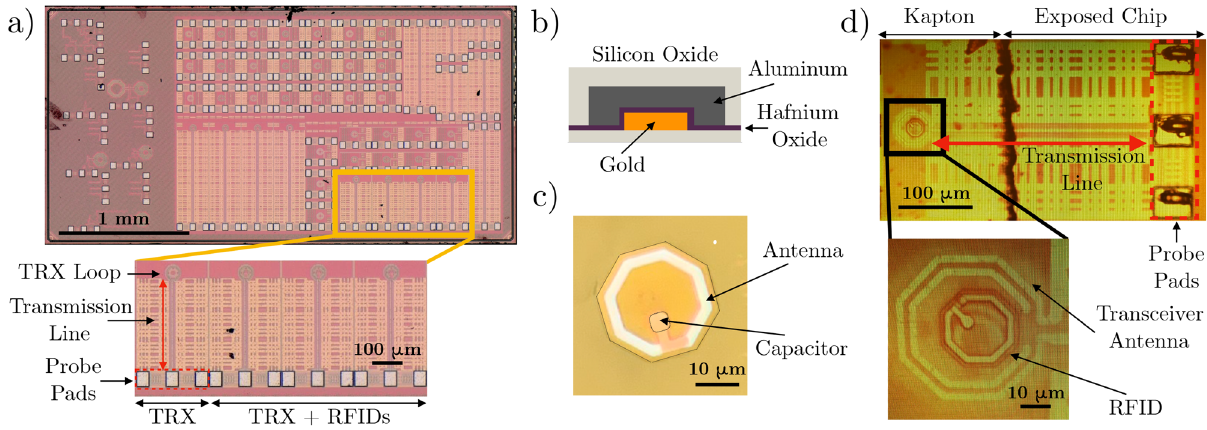
Figure 2. Hardware components of the intracellular detection system. ( a ) Transceiver structures are fabricated on an integrated circuit. Each chip includes a standalone transceiver and three transceivers with concentric, integrated RFIDs. Each transceiver loop is connected to a 300 µ m transmission line and probe pads. ( b ) Schematic cross section of RFIDs fabricated in the Stanford Nanofabrication Facility (SNF). ( c ) Top view of a loose RFID device. The device consists of an antenna (white outer ring) and a capacitor (square feature situated inside the ring), whose size and value can be modified during fabrication to generate different RFID batches with different electrical characteristics. ( d ) Using Kapton film as a carrier, individual RFIDs can be placed within the footprint of the transceiver antenna to be detected and identified. The probe pads must be uncovered to perform electrical sensitivity is achieved when the RFID is placed fully within the transceiver loop. Thus, we are motivated to replicate this configuration experimentally to realize the largest possible electrical measurement change. Due to small sizes of the RFIDs and transceiver loops, manual placement and alignment is difficult. Rather than handling individual devices, we dispense a droplet of the RFIDs in isopropyl alcohol onto a 5 mm × 5 mm sheet of 7.6 µ m thick Kapton Film (CS Hyde) coated with a thin layer of semi-cured polydimethylsiloxane (PDMS). After the isopropyl alcohol evaporates, we end up with a carrier film of Kapton coated with a random dispersion of RFIDs. Concurrently, the integrated chip is embedded in a sheet of PDMS to aid handling. Using a flip chip bonder, the entire Kapton film can be picked and placed relative to the transceiver feature on the integrated chip with sub-micron accuracy (Fig. 2d). With the development of this alignment and placement technique, it